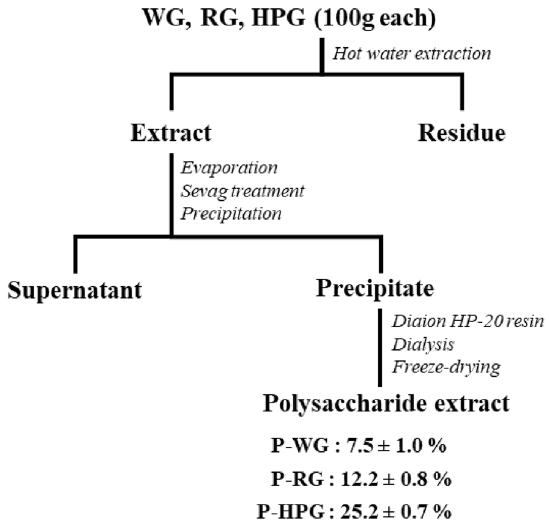
Fig. 2 Preparation (extraction scheme) and chemical properties of P‑WG, P‑RG, and P‑HPG